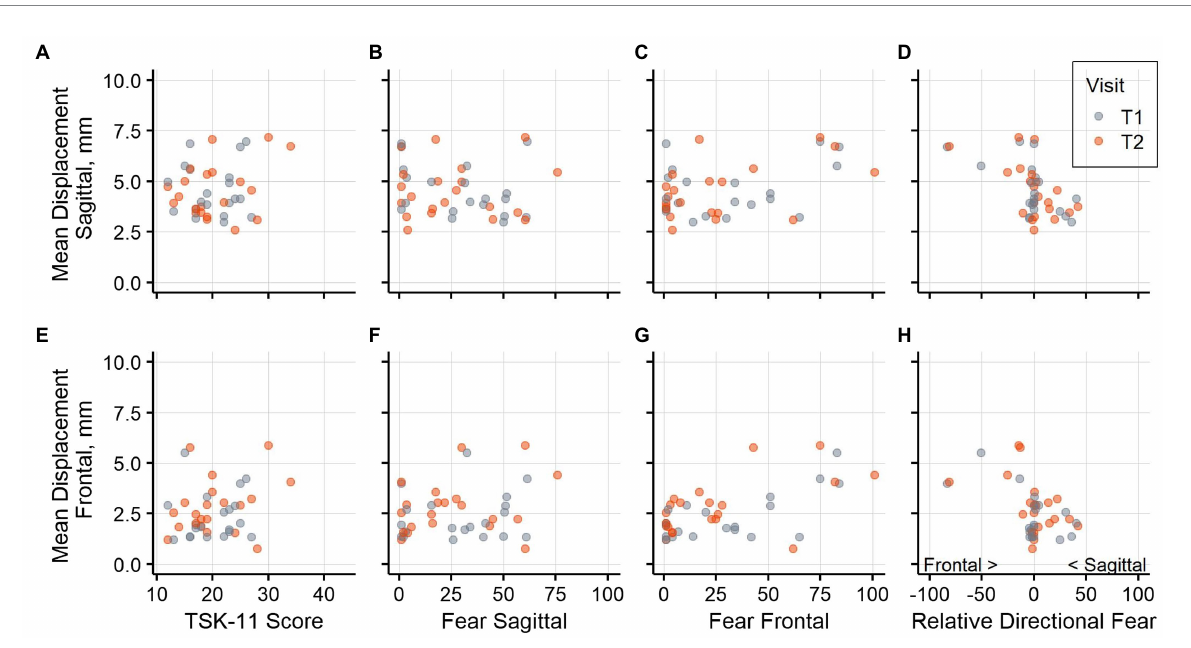
FIGURE 3 Postural sway displacement and fear variables. Association of postural sway displacement in the sagittal plane and (A) general fear, (B) fear of sagittal plane movement, (C) fear of frontal plane movement, (D) relative directional fear. Association of postural sway displacement in the frontal plane and (E) general fear, (F) fear of sagittal plane movement, (G) fear of frontal plane movement, (H) relative directional fear. Negative values for relative directional fear show higher fear of frontal plane movements and positive values show higher fear of sagittal plane movements. Data from assessment visit T1 is shown in blue and data from T2 in